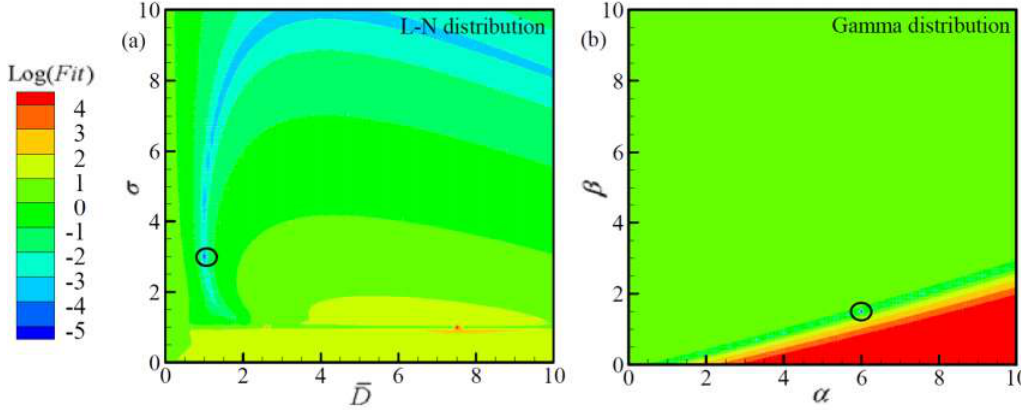
Figure 7. Distribution of the objective function values for different ASDs by using the ALSM: ( a ) L-N distribution; ( b ) Gamma distribution.